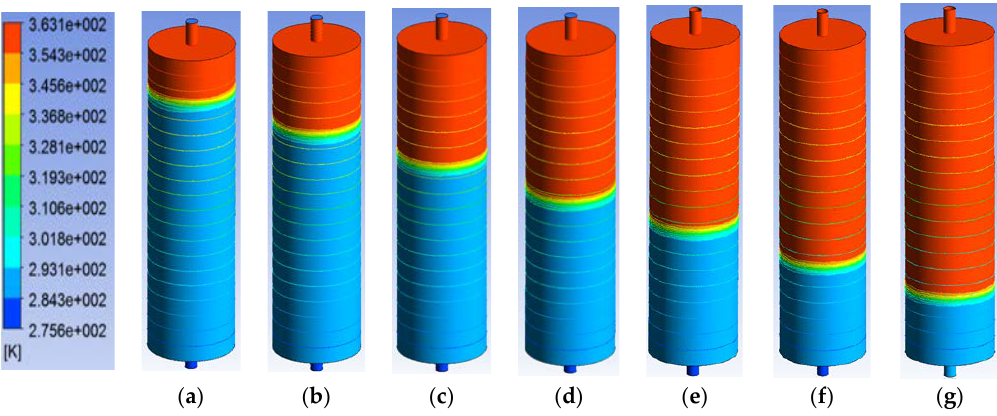
Figure 10. Temperature profiles in TES-1 at different inlet velocities: ( a ) 8 cm/s; ( b ) 7 cm/s; ( c ) 6 cm/s; ( d ) 5 cm/s; ( e ) 4 cm/s; ( f ) 3 cm/s; ( g ) 2 cm/s.